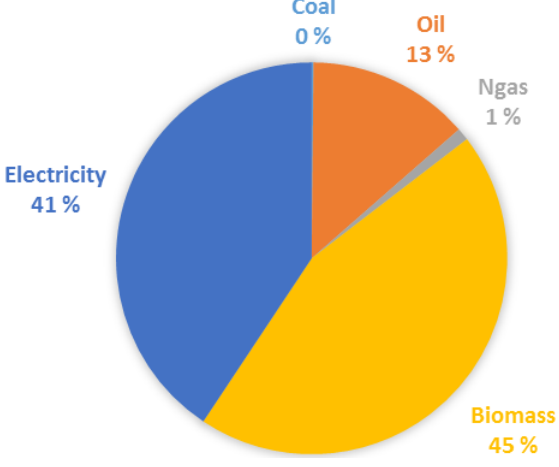
Figure 13. Fuel used for individual heating in Finland.